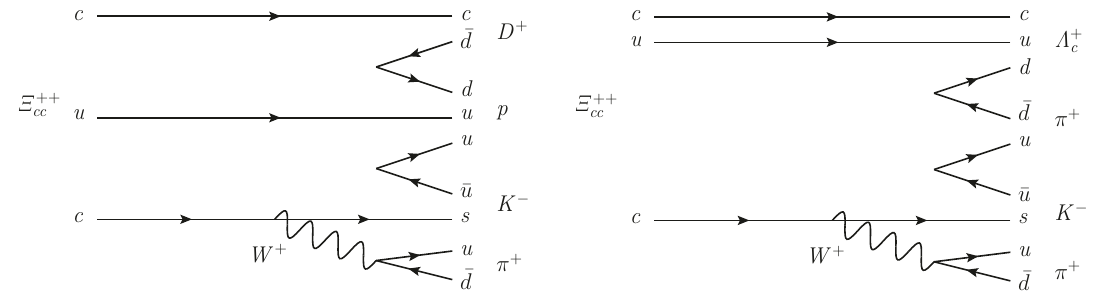
D + pK (cid:0) (cid:25) + decay cc !